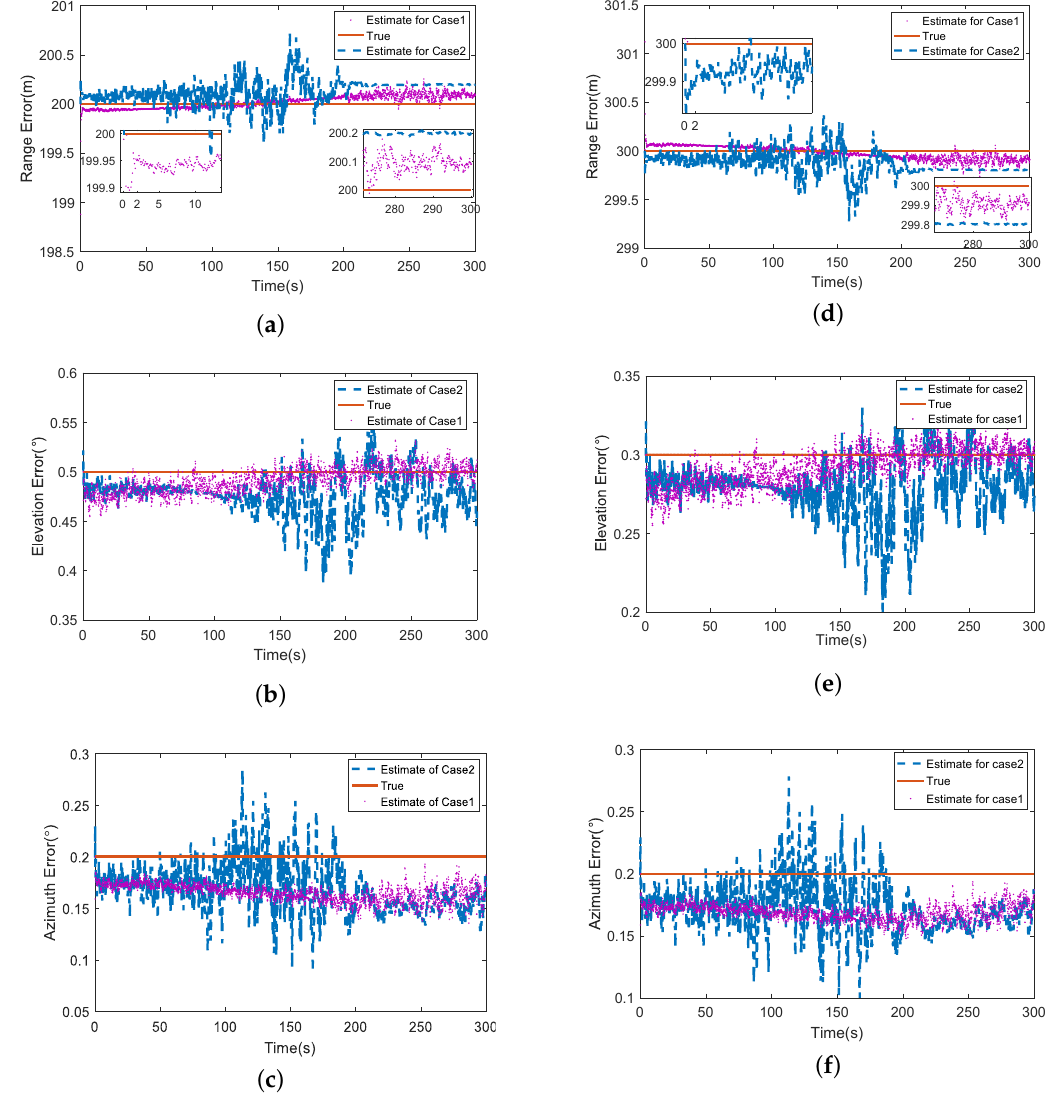
Figure 6. ( a ) The estimation of range error of missile 1; ( b ) The estimation of elevation error of missile 1; ( c ) The estimation of azimuth error of missile 1; ( d ) The estimation of range error of missile 2; ( e ) The estimation of elevation error of missile 2; ( f ) The estimation of azimuth error of missile